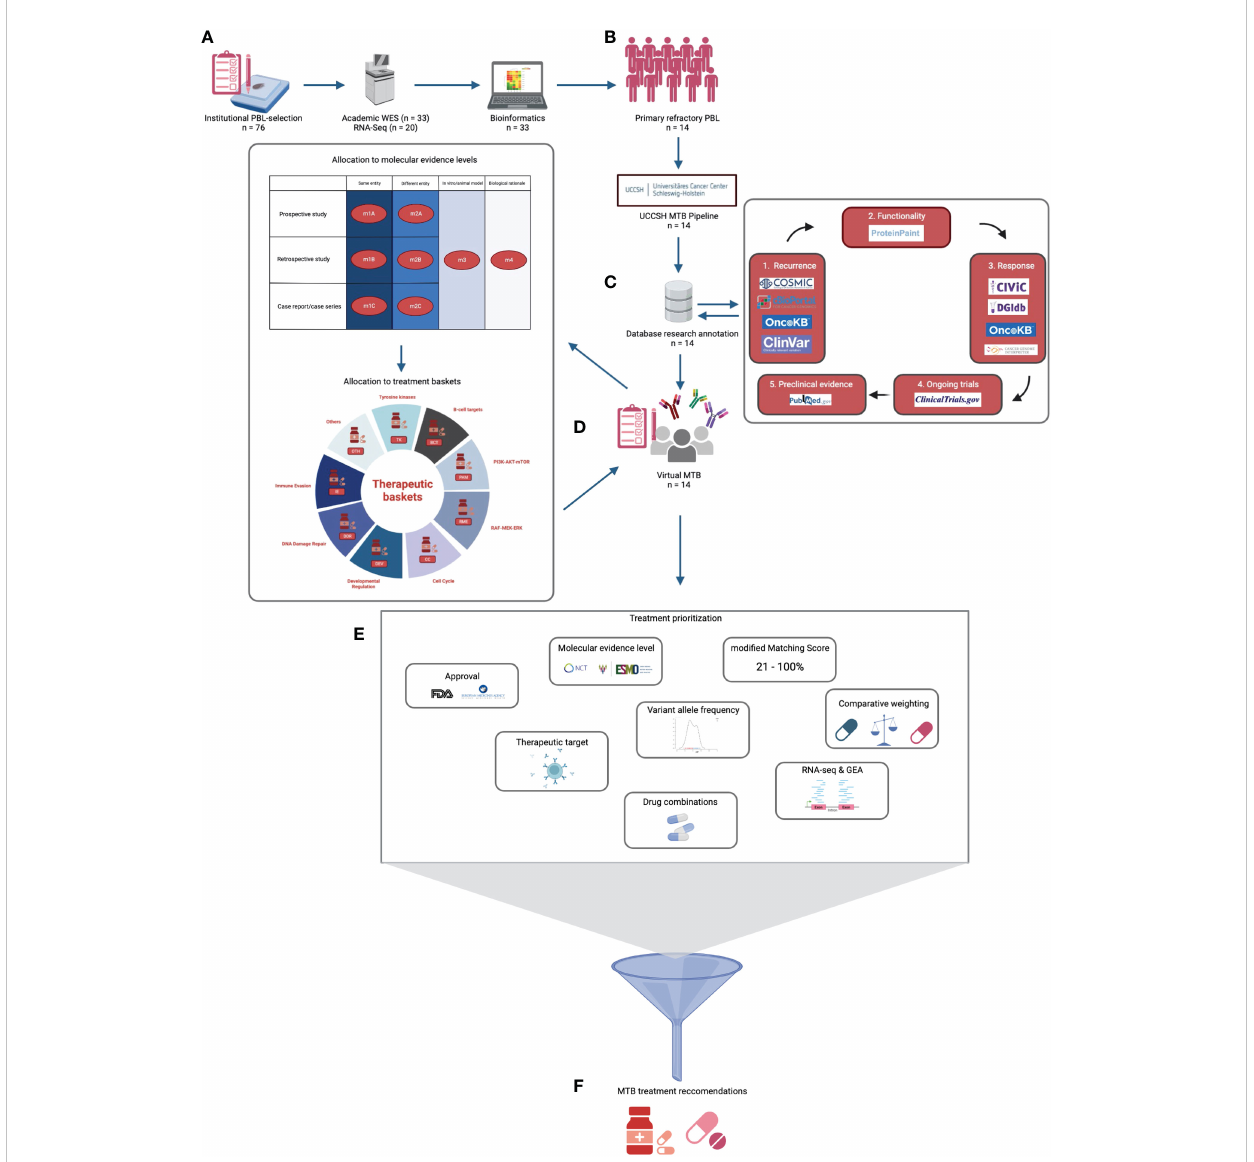
FIGURE 1 Virtual UCCSH molecular tumor board work fl ow for primary refractory plasmablastic lymphomas (prPBL). (A) After institutional PBL selection, academic WES and RNA-seq were performed in 33 and 20 cases, respectively. (B) Consecutively, 14 prPBL cases were identi fi ed and underwent UCCSH MTB pipeline evaluation. (C) Afterwards, manual database research annotation was conducted for each relevant variant. (D) In a virtual MTB setting, each prPBL case was discussed. Potential therapeutic vulnerabilities were allocated to molecular evidence levels and to treatment baskets. (E) Multifactorial treatment prioritization process revealed (F) MTB treatment